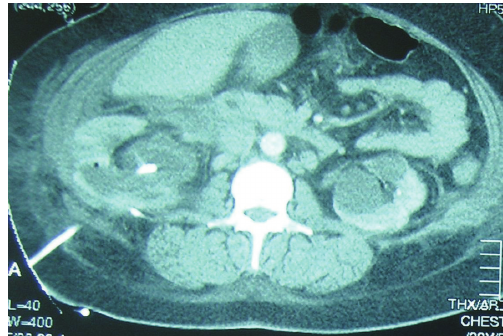
Figure 4: Case 2: CT scan showing the placement of nephrostomy